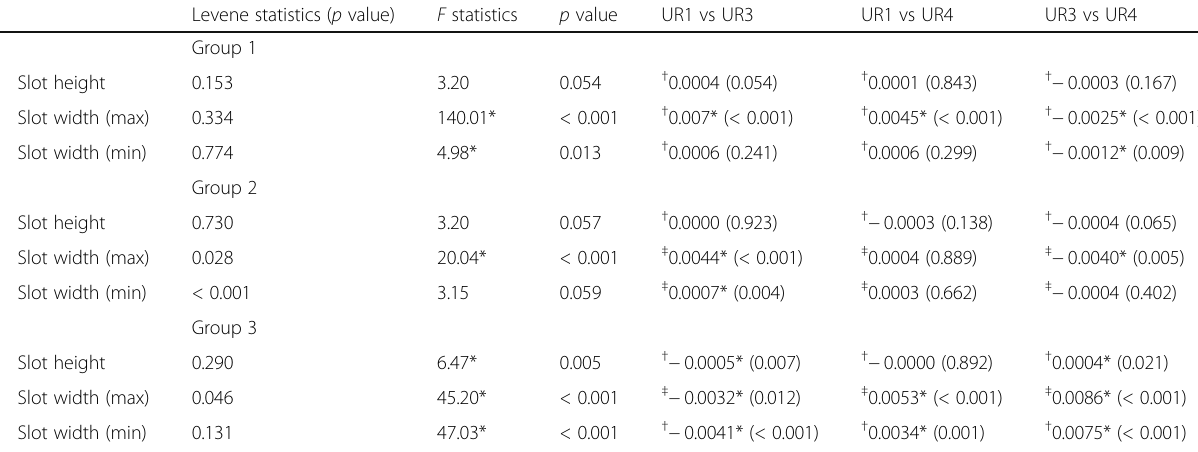
Table 3 Results of one-way ANOVA, divided by each group, comparing slot measurements for different bracket types Levene statistics ( p value) F